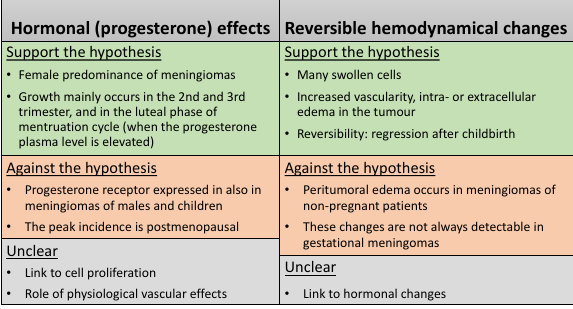
Table 1: The two dominant hypothesis for rapid growth in gesta- tional meningioma